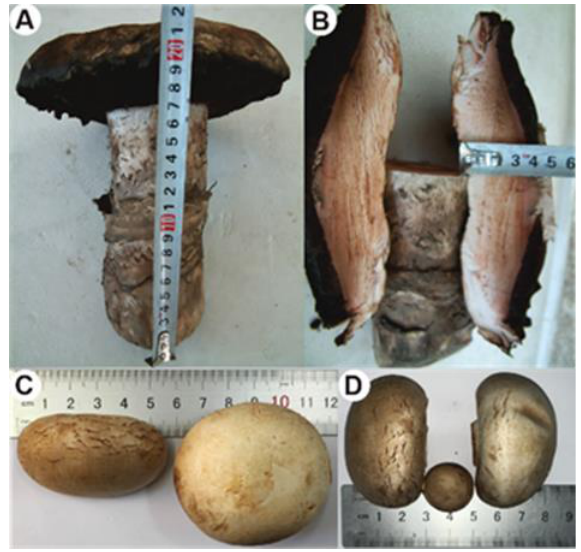
Figure 1. Morphologic comparison in size of the genus Agaricus mushrooms. ( A , B ) The fruiting bodies of wild A. bitorquis BH01. ( C , D ) The fruiting bodies of cultivated A. bisporus var. bisporus H97.